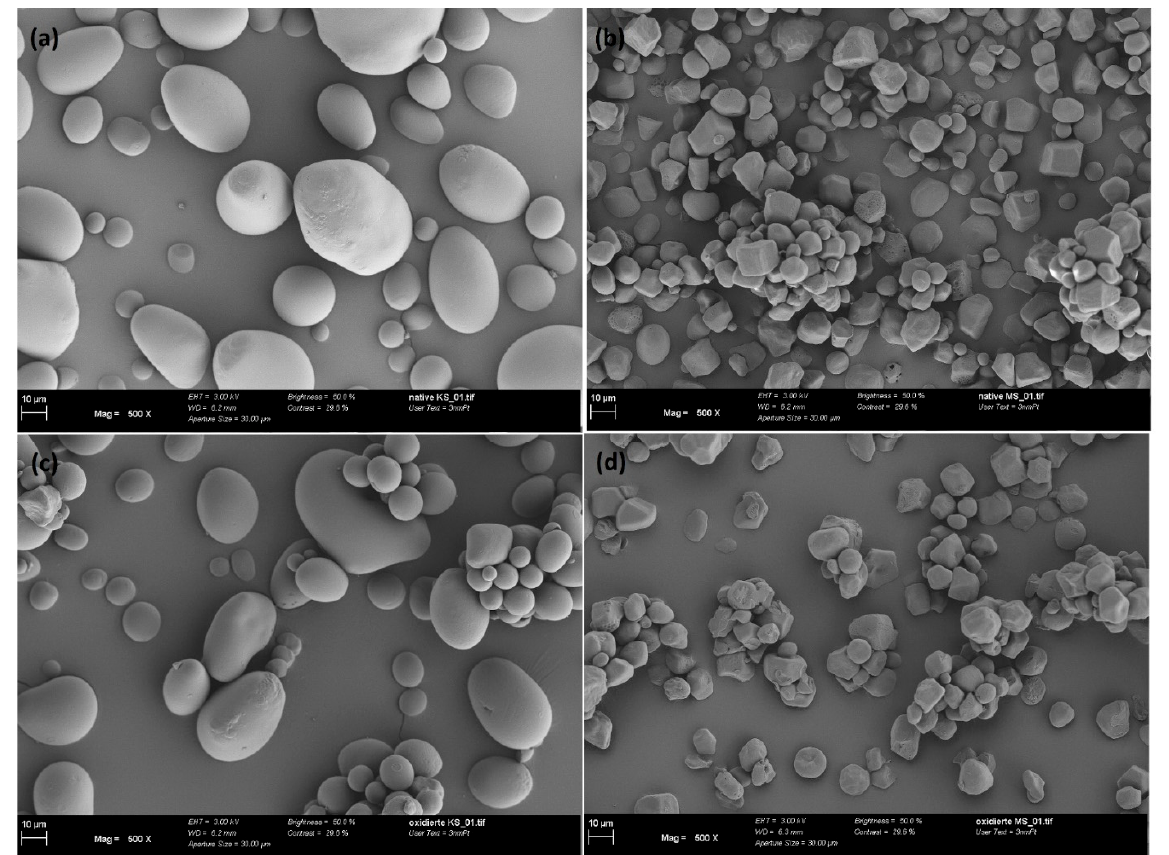
Figure 1. The streaming potential of starches as a function of pH in the pH range of 3 to 9 on native potato starch (blue), native corn starch (red), oxidized potato starch (light blue), and oxidized corn starch (pink). These data were reported recently by our author team [16].